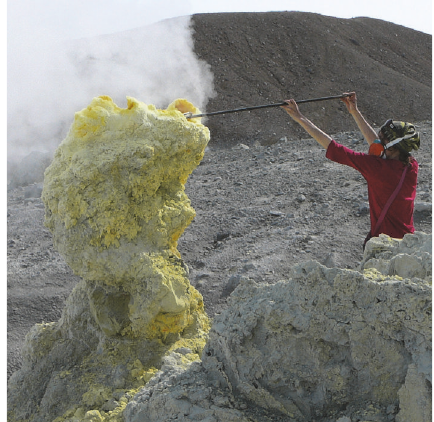
Figure 2: Fumarole edifice, the Southeast field, Ebeko volcano. Photo by T.